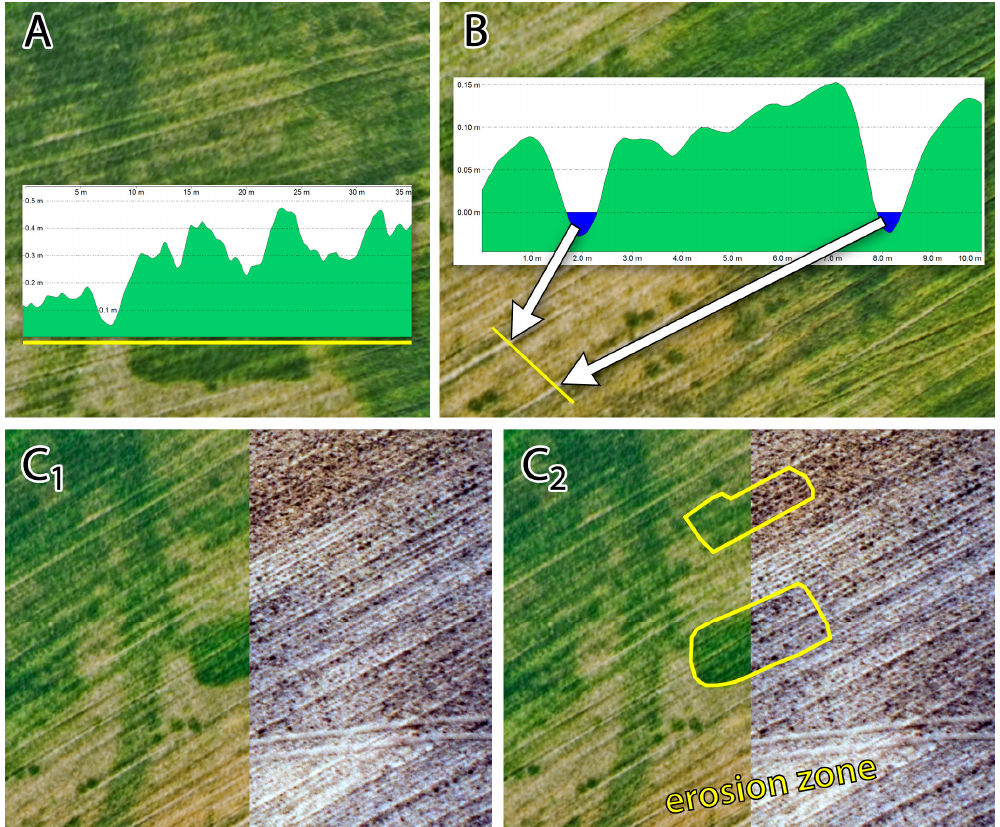
Figure 6. Insets ( A , B ) illustrate the correspondence between the vegetation orthophoto and the elevation values of the CHM, while insets ( C 1 ) and ( C 2 ) show that some vegetation marks correlate very well with the distinct soil